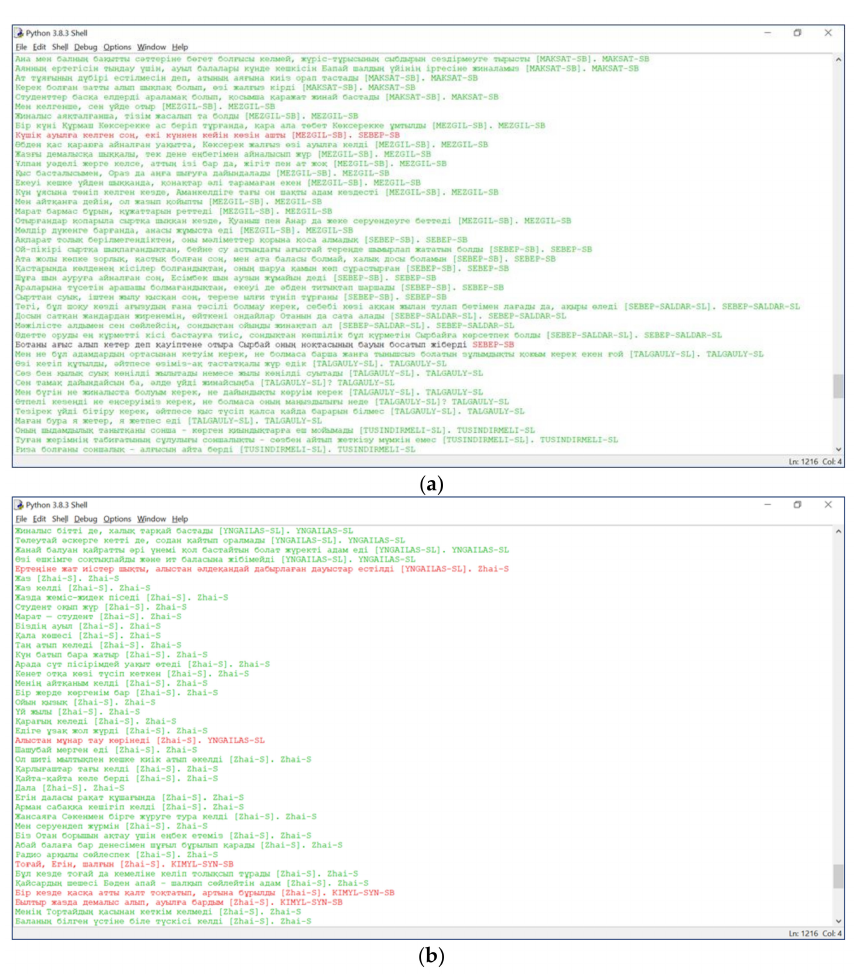
Figure 1. Calculating the similarity weight of a sentence to a pattern of complex sentence types using the FuzzyWuzzy package.